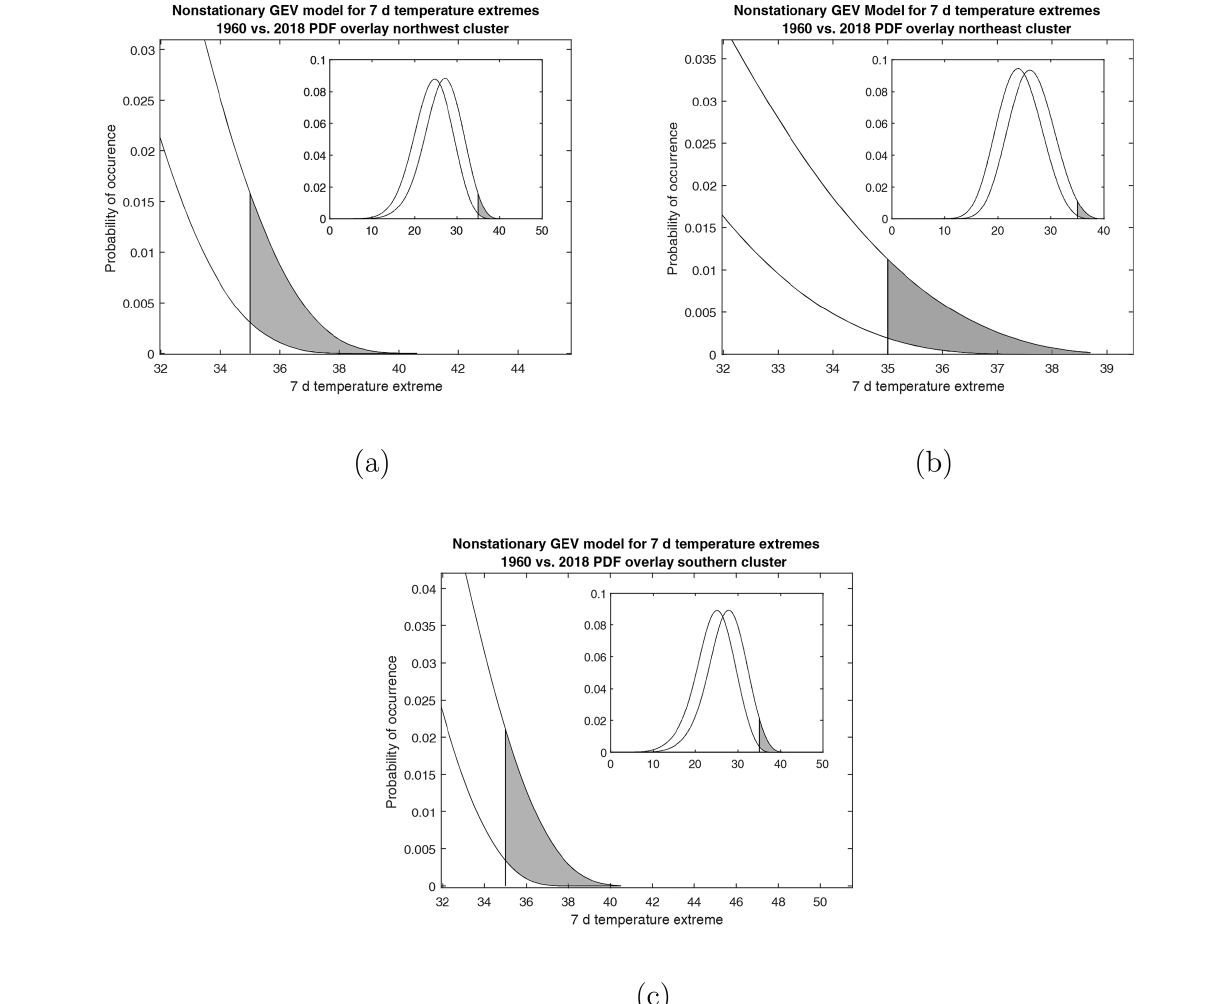
Figure 10. Nonstationary generalized extreme value model overlay of 1960 and 2018 weekly temperature extremes for the (a) northwest (b) northeast, and (c) south regional clusters. The shaded region indicates the probability of observing a weekly extreme higher than 35 ◦ C.